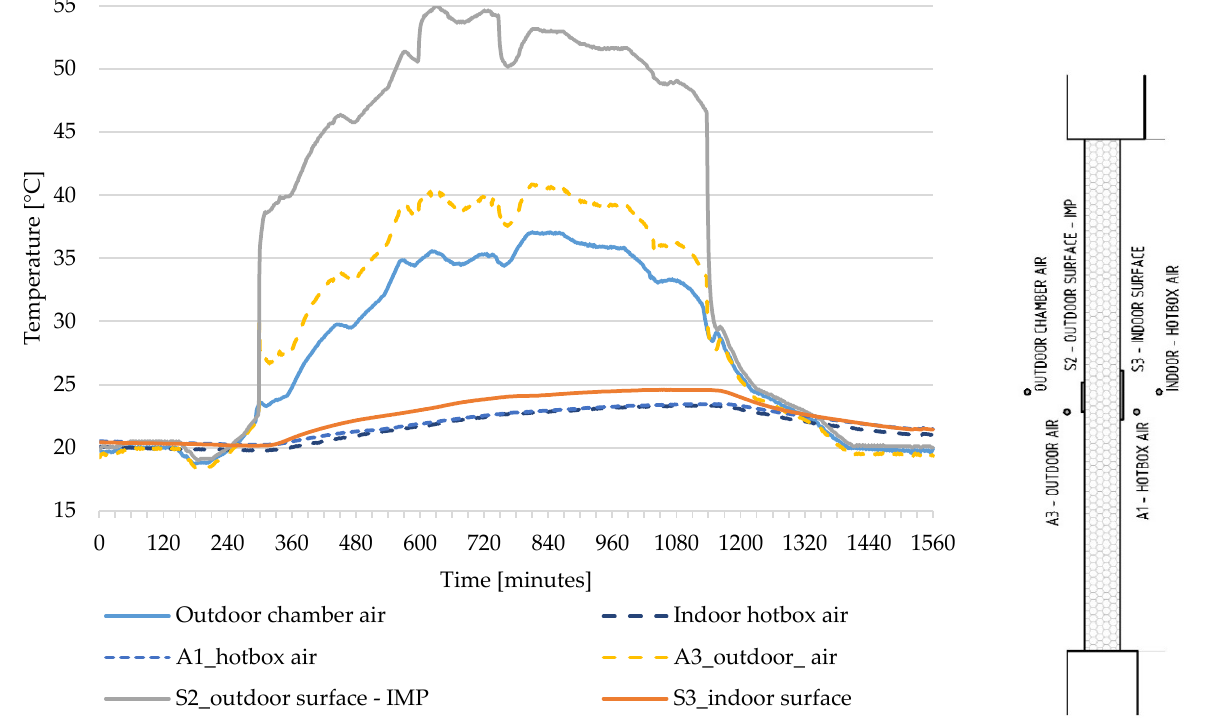
Figure 5. The temperature course for the setup without the vegetation board. Increase in S3 indoor surface temperature from 20.1 to 24.6 °C (temperature difference Δθ si = 4.5 K).